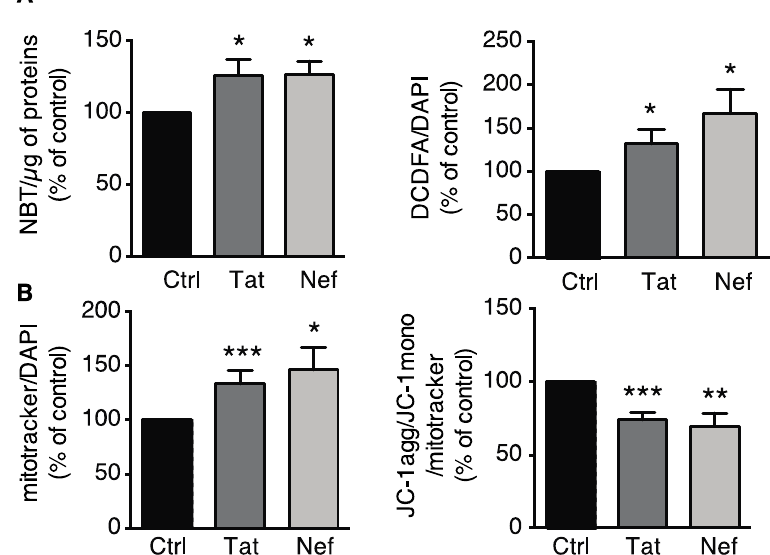
Figure 4. Treatment of ASCs with Tat or Nef resulted in higher oxidative stress and mitochondrial dysfunction. ( A ) After 15 days of treatment with Tat or Nef in ASCs, isolated from different abdominal SCAT healthy donors, reactive oxygen species (ROS) production was assessed spectroscopically by measuring the nitro blue tetrazolium (NBT) absorbance (normalized against protein content) and the CM-H 2 DCFDA fluorescence (normalized against DAPI) ( n = 9, in duplicate). ( B ) Mitochondrial mass was evaluated using MitoTracker Red dye. The cationic dye JC-1 was used to evaluate the mitochondrial membrane potential. The fluorescence results are expressed as the mean ± SEM % JC-1 aggregate / monomer ratio, relative to control cells ( n = 9, in duplicate). * P < 0.05, ** P < 0.01, *** P < 0.001 vs. control